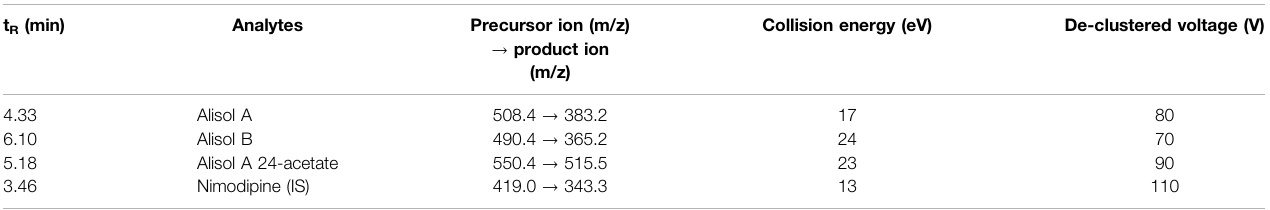
TABLE 1 | The mass spectrometry parameters for analytes.